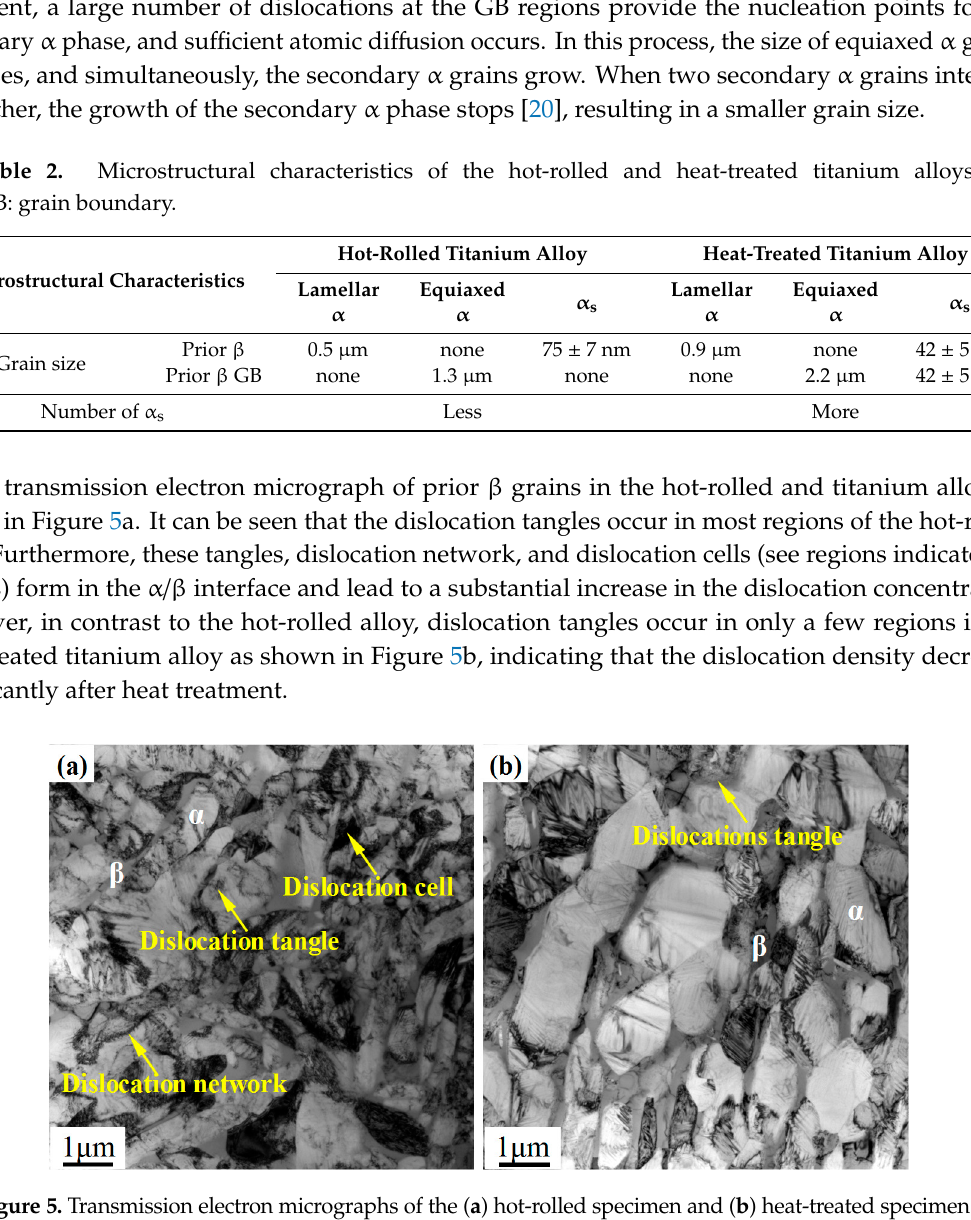
Figure 5. Transmission electron micrographs of the ( a ) hot-rolled specimen and ( b ) heat-treated specimen.